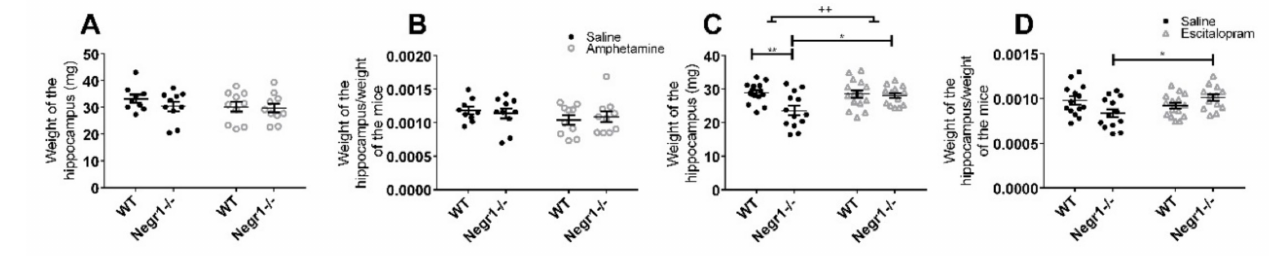
Figure 6. Hippocampi of Negr1 − / − mice weigh less compared to WT mice, and escitalopram restores the weight of the hippocampi of Negr1 − / − mice. ( A ) The weight of the hippocampi of the mice after receiving 10 days of saline or amphetamine. ( B ) Weight of hippocampi divided by the weight of mice (after receiving 10 days of saline or amphetamine). ( C ) Weight of hippocampi of the mice receiving 23 days of saline or escitalopram. ( D ) Weight of hippocampi divided by the weight of mice (after receiving 23 days of saline or escitalopram). Data represent mean ± SEM, ++ p < 0.01—genotype effect, * p < 0.05, ** p < 0.01—post hoc test, ordinary two-way ANOVA (Bonferroni post hoc